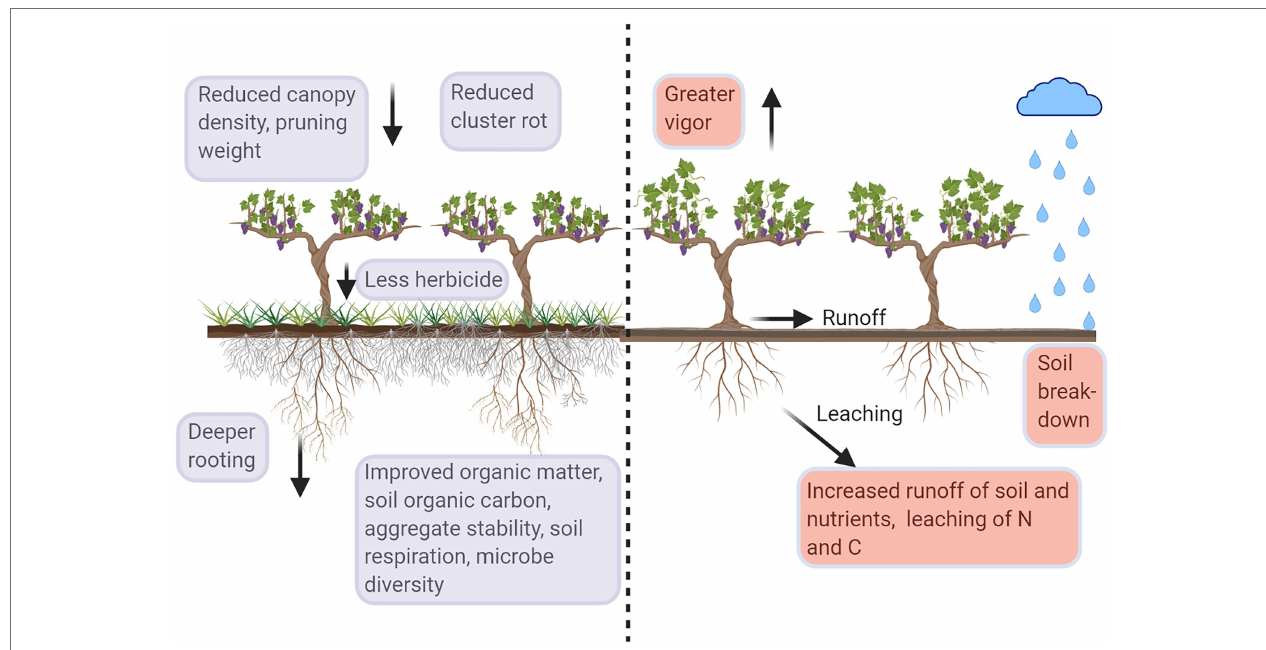
FIGURE 1 | Diagrammatic representation of the impact of soil management, under-vine vegetation (UVV) vs. bare soil, on grapevines and soil. Violet boxes represent ecosystem services in vineyards with high-vigor potential; red boxes represent ecosystem disservices. Figure created with